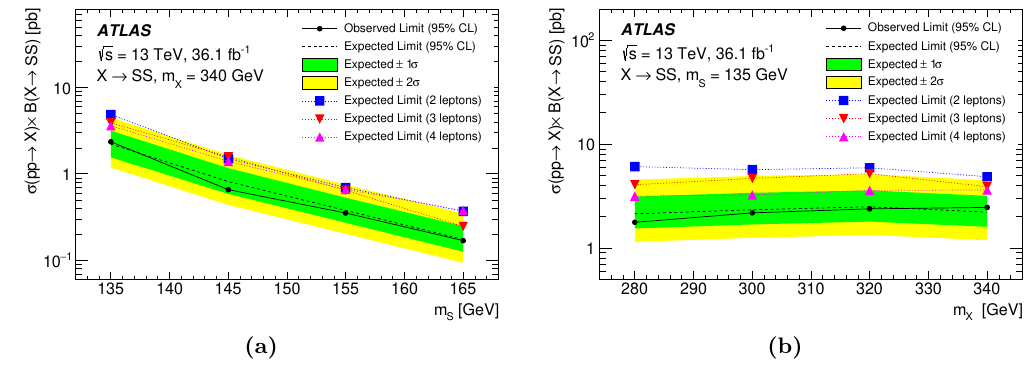
Figure 4 . Expected and observed 95% CL exclusion limits set on the cross-section times branching ratio of resonant X ! SS production as a function of (a) m S and (b) m X . Limits are shown for each channel individually as well as for the combination of the channels. Statistical and systematic uncertainties are included.